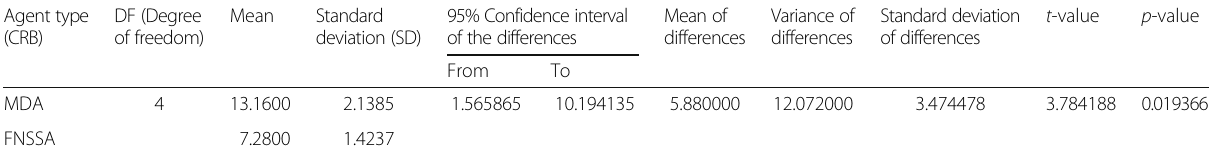
Table 13 Significant results of t-test statistical method for negotiation time metric in marketplaces which are made based on